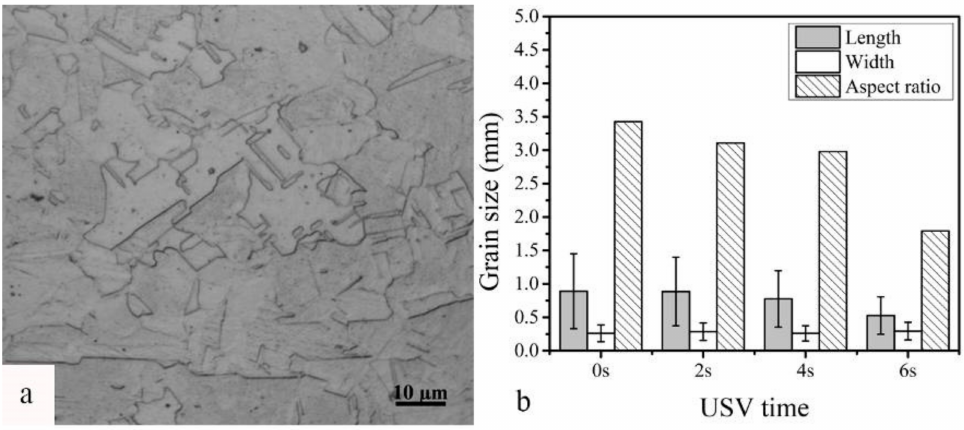
Figure 5. ( a ) The microstructure of the BM; and ( b ) the grain size and aspect ratio for GTA spot-welded copper joints with different USV